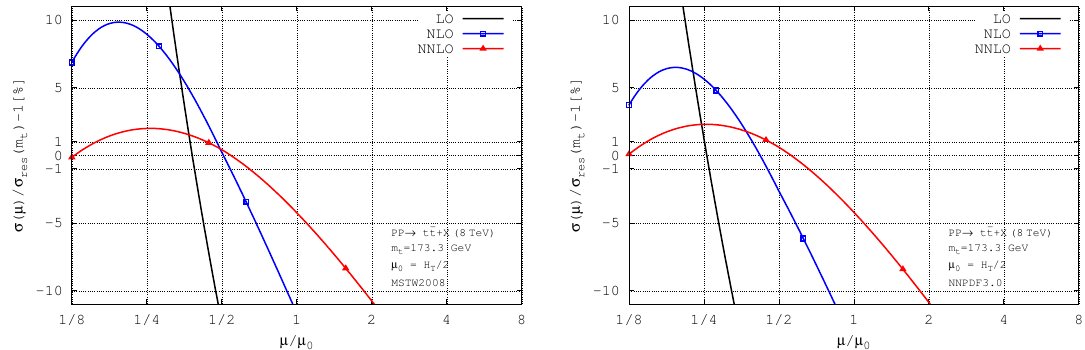
Figure 2 . Total cross-section at LO, NLO and NNLO evaluated with a dynamic scale (cid:22) F = (cid:22) R = H T = 2 (de(cid:12)ned in eq. (3.3)) with two di(cid:11)erent pdf sets: MSTW2008 (left) and NNPDF3.0 (right). Each plot is normalised as in (cid:12)gure 1, i.e. to the NNLO+NNLL cross-section evaluated with the corresponding pdf set at scale (cid:22) 0 = m t . The symbols on some of the lines are meant to help distinguish the various lines.